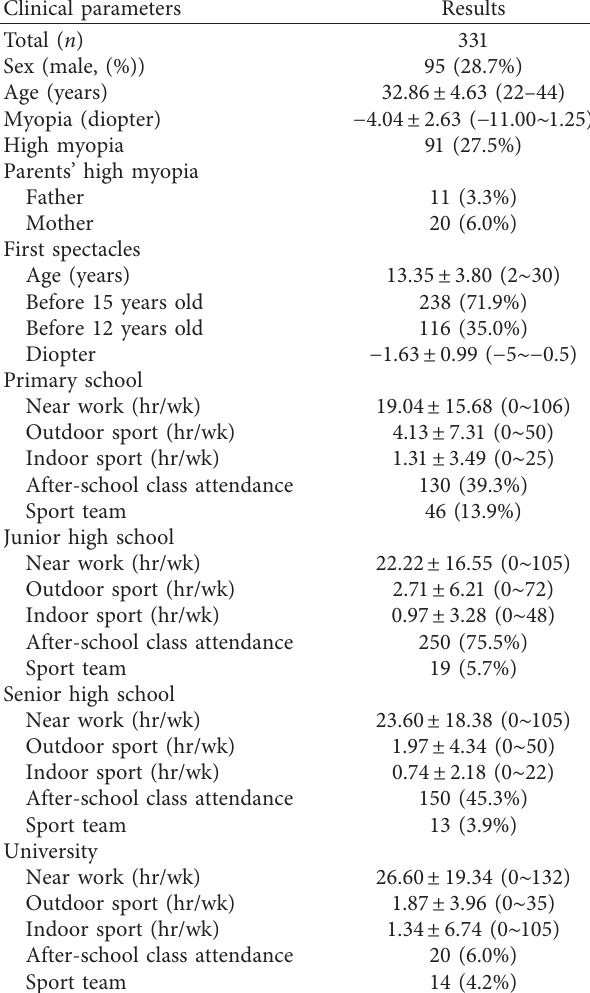
Table 1: Demographics and baseline results of all participants. Clinical parameters